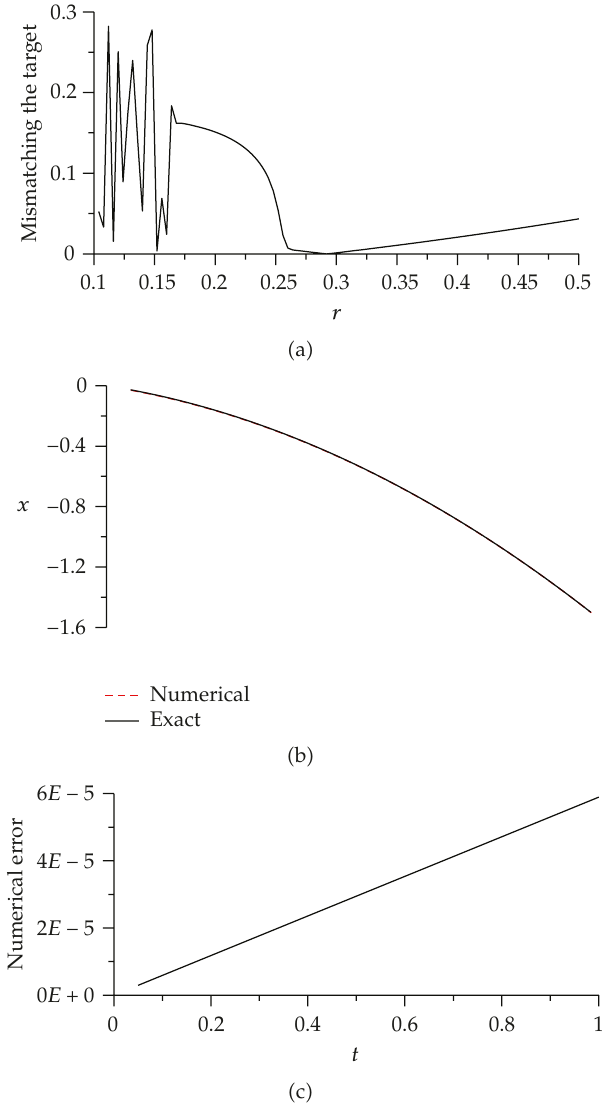
Figure 2: For example 1: (cid:3) a (cid:4) showing the error of mismatching, (cid:3) b (cid:4) comparing numerical and exact solutions, and (cid:3) c (cid:4) displaying the